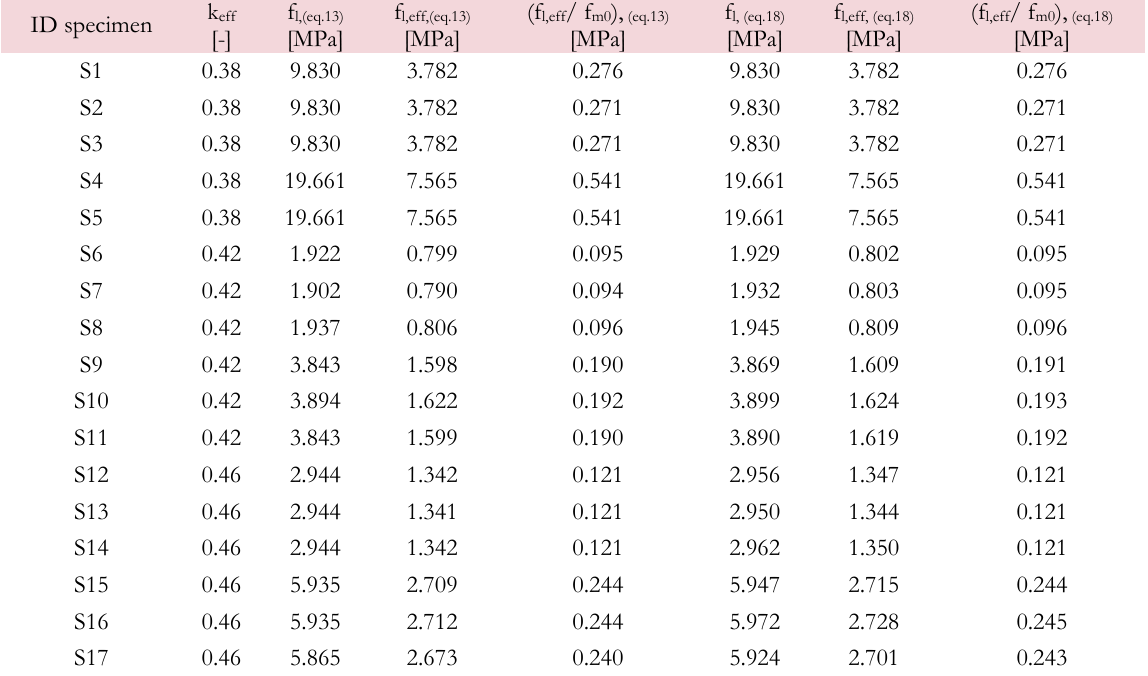
Table 2.B: Effective confining stress calculated according to Eqns. (13) and (18) for the experimental program,